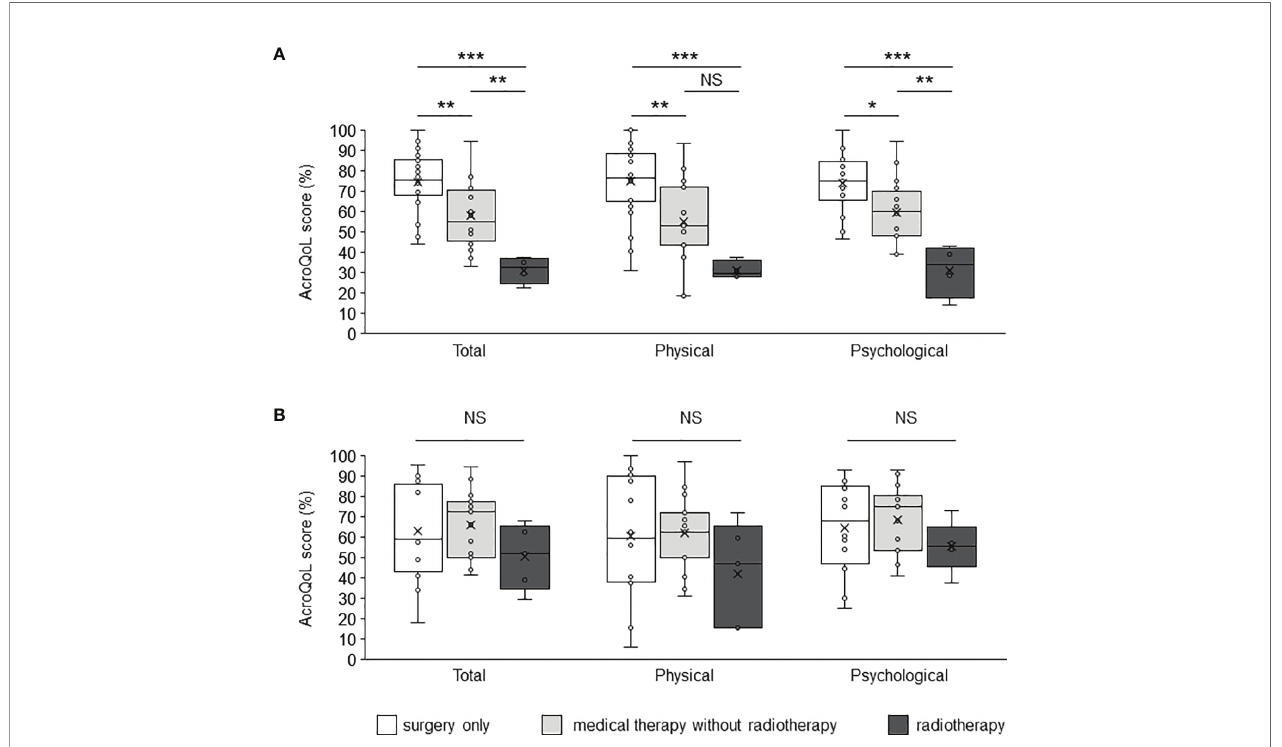
FIGURE 3 | Comparison of the AcroQoL scores of the subgroups based on treatment modalities. Comparison of the AcroQoL scores of the subgroups treated with surgery only, medical therapy without radiotherapy, and radiotherapy in the (A) young and middle-aged, and (B) older groups. Individual scores have been plotted, and the median values and interquartile ranges are presented in a box plot. NS, not signi fi cant, * P < 0.05, ** P < 0.01, *** P <